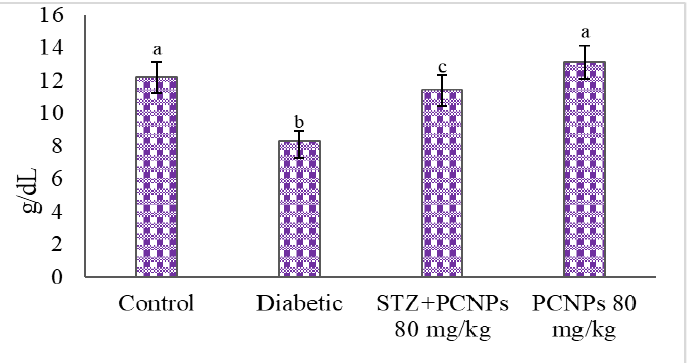
Figure 3. Activities of PCNPs on Hb of experimental and control group. Values are means ± SD for six rats at p < 0.05 (DMRT). a PCNPs alone treated group compared with control group. b Diabetic group compared with control group. c Treatment group compared with diabetic control.